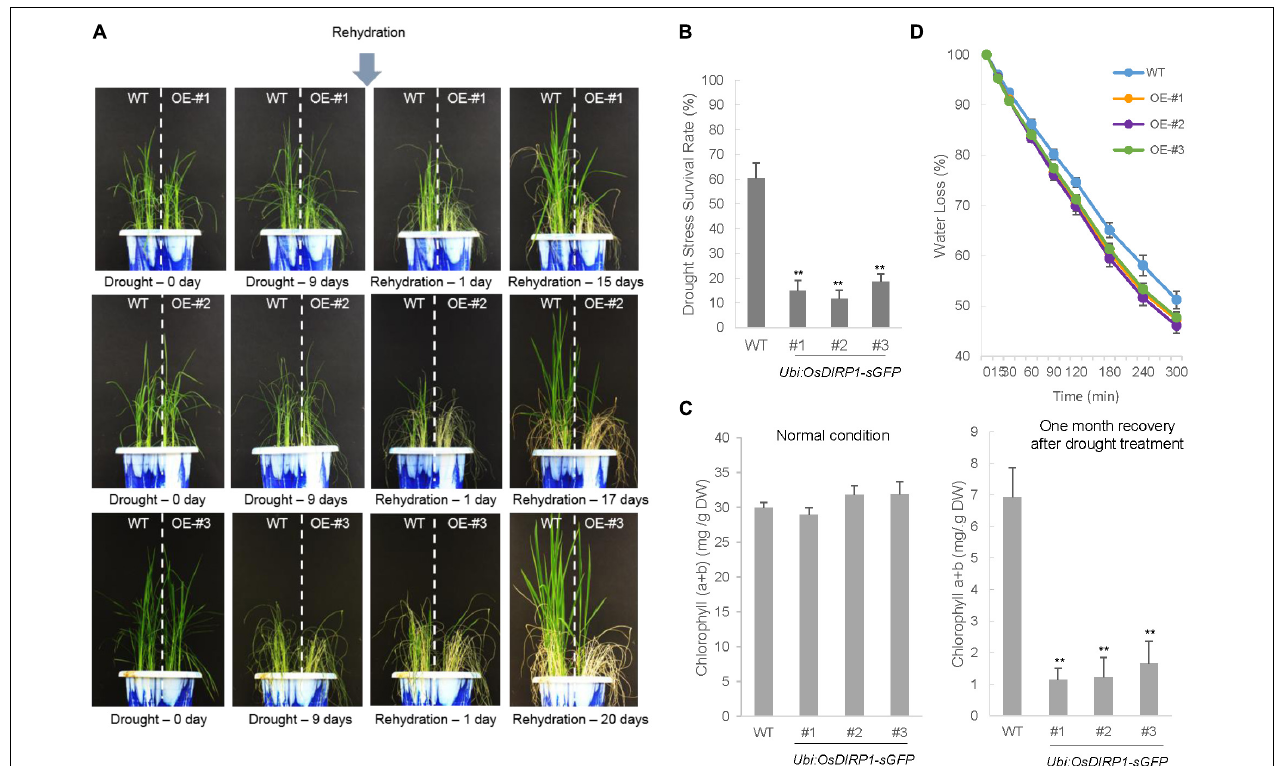
FIGURE 3 | Decreased tolerance of Ubi:OsDIRP1-sGFP transgenic rice plants to drought stress. (A) Drought stress phenotypes of wild-type and T4 Ubi:OsDIRP1-sGFP transgenic rice plants. Light-grown, 5-week-old wild-type (WT) and T4 Ubi:OsDIRP1-sGFP (lines #1, #2, and #3) plants were grown for 9 days without watering (drought stress). After 9 days of dehydration, these plants were re-watered, and their growth patterns were monitored for 15–20 days after re-watering. OE represents OsDIRP1 -overexpressing transgenic rice plants. (B) Survival rates of the wild-type (WT) and T4 Ubi:OsDIRP1-sGFP plants in response to drought stress. Data are means ± SE ( n ≥ 6 independent biological experiments; > 30 plants were used in each assay, ∗∗ P < 0.01, Student’s t -test). (C) Total leaf chlorophyll content of wild-type and T4 Ubi:OsDIRP1-sGFP (lines #1, #2, and #3) plants before and after drought treatment. The chlorophyll content of mock-treated (before drought) and drought-treated plants was measured after 1 month of rehydration. Data are means ± SE ( n ≥ 3 independent biological experiments; > 30 plants were used in each assay, ∗∗ P < 0.01, Student’s t -test). (D) Water loss rates of detached leaves. The leaves of 5-week-old wild-type and T4 Ubi:OsDIRP1-sGFP (lines #1, #2, and #3) plants were detached, and their fresh weights were measured at the indicated time points. Data are means ± SD ( n = 3 independent biological experiments; > 6 plants of each genotype were used in each